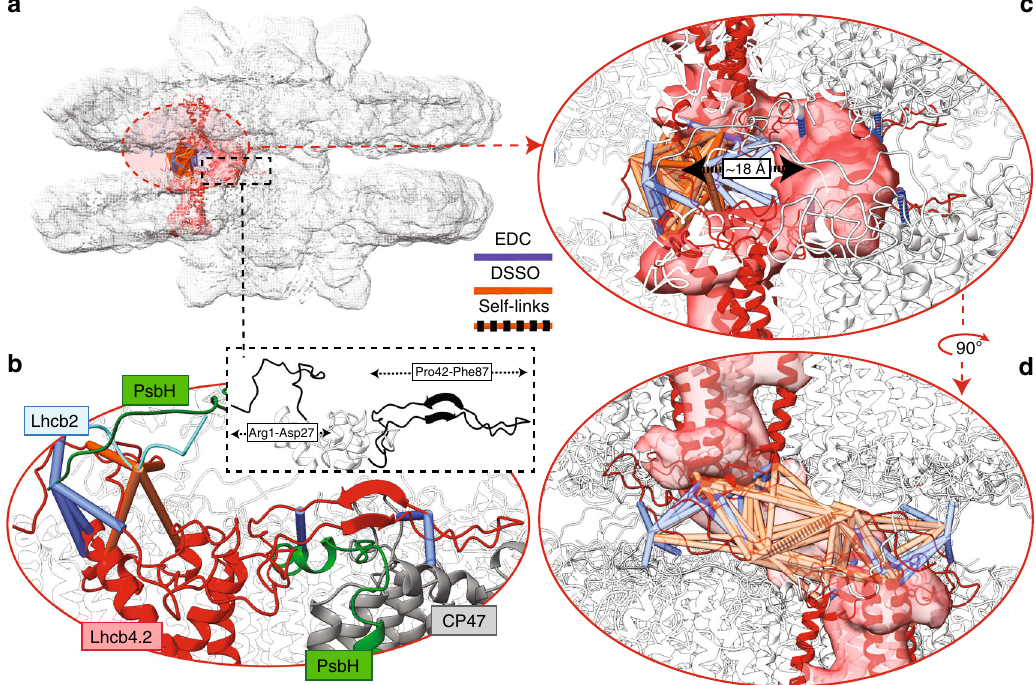
Fig. 4 Mapping of Lhcb4.2 crosslinks putatively responsible for the structural anchor of paired PSII – LHCIIsc. a Side-view of the (C 2 S 2 M)x2 fi tted in the cryo-EM map EMD-3825, with the “ knot ” connecting density highlighted in red. b Enlarged view highlighting the inter-protein crosslinks involving the N-terminus (Arg1 – Asp27) and the long hairpin (Pro42 – Phe87) of Lhcb4.2. These two regions of the N-terminal loop of the Lhcb4.2 are shown in black in the inset. Side-view c and end-view d of the putative site of interaction between the fl exible N-termini (Arg1 – Asp27) of two Lhcb4.2 subunits facing from adjacent supercomplexes are shown, and their ~18 Å displacement from the “ knot ” density is indicated. Crosslinks within the distance cut-off of 17 Å for EDC (blue lines) and of 33 Å for DSSO (orange lines), and DSSO self-links (orange-black dashed lines) are shown. Subunits are coloured as follows: Lhcb2 in cyan; Lhcb4.2 in red; PsbH in green and CP47 in grey. Subunits not involved in crosslinks are left